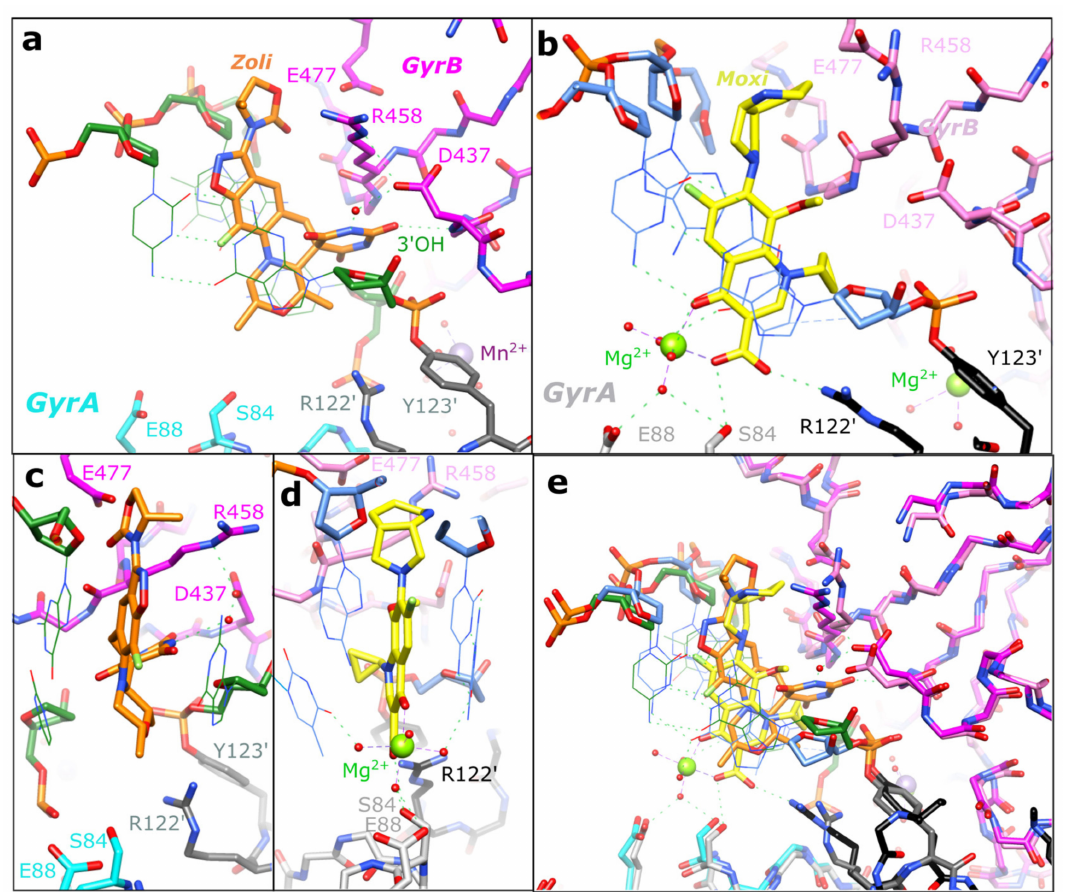
Figure 4. Equivalent views of zoliflodacin and moxifloxacin in S. aureus DNA gyrase DNA cleav- age complexes . ( a ) A close-up view of a zoliflodacin (Zoli: orange carbons) binding site in the 2.8 Å structure. The pyrimidinetrione moiety of zoliflodacin interacts directly and indirectly (via a water) with Asp437 of GyrB (dotted green lines), in a similar manner to that described in the 2.5 Å QPT-1 structure. Y123 (cid:48) has cleaved the DNA and formed a ‘phosphotyrosine’ type linkage with the cleaved DNA. The DNA-backbone is shown with a fatter ‘stick’ representation, with the bases drawn in thinner ‘line’ (base-pair H-bonds only shown for the +1, +4 base-pair). ( b ) In the 2.95 Å moxifloxacin (Moxi: yellow carbons) structure, the quinolone-bound Mg 2+ ion (green sphere) and coordinating water molecules (red spheres) make hydrogen bonds (dotted red lines) to S84, E88, and the bases either side of the DNA cleavage site (at the +1 and -1 positions; see panel d). ( c , d ) Orthogonal (90 ◦ ) views of the compound binding sites in the zoliflodacin structure ( c ) and moxifloxacin structure ( d ). ( e ) Superposition of ( a , b ). Figure produced using ChimeraX